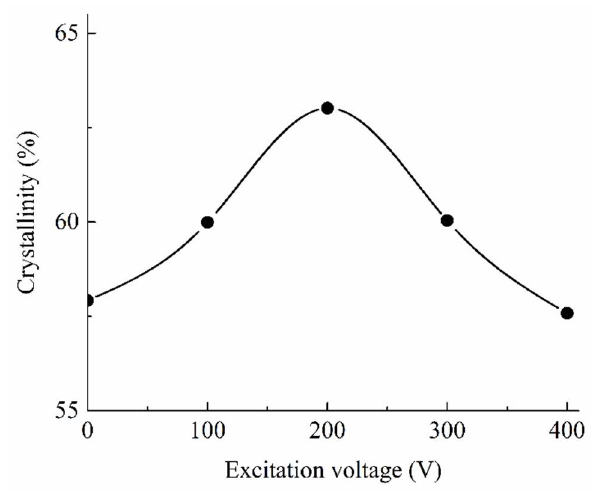
Figure 8. The crystallinity versus the excitation voltage of the PP parts.